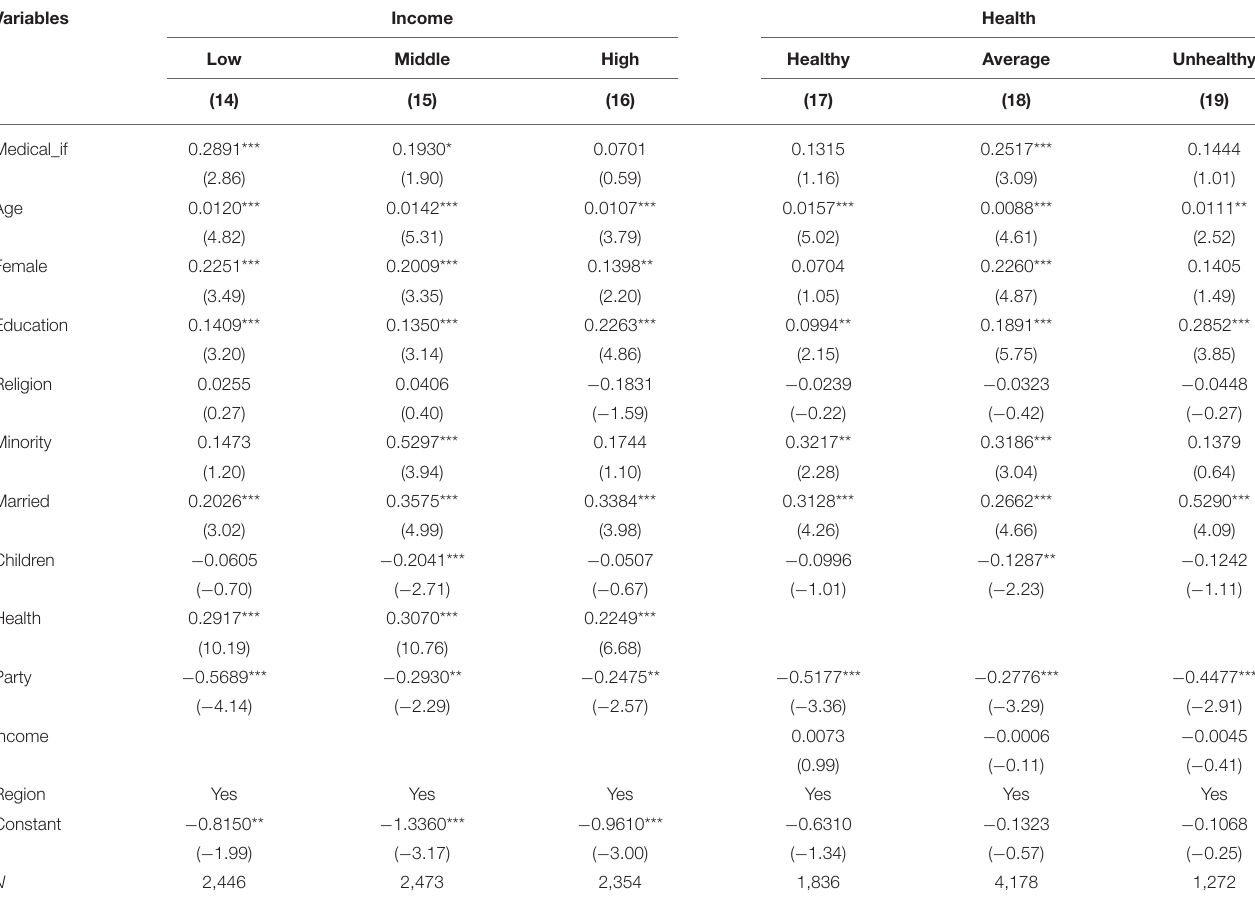
TABLE 7 | Results of heterogeneity analysis.